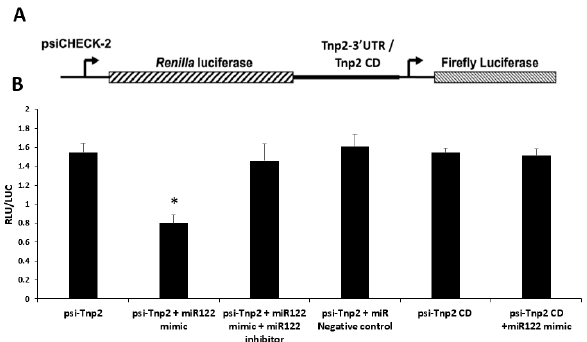
Figure 8. Tnp2 mRNA–miRNA122a interaction. Modulation of translation of Tnp2 depends on the presence of Tnp2 3 ′ UTR region. ( A ) Schematic representation of the psiCheck2 reporter gene carrying the Tnp2 coding sequence with or without 3 ′ UTR. ( B ) Relative luciferase activity in COS-1 cells co-transfected with Tnp2 with 3 ′ UTR reporter constructs (or Tnp2 coding region without 3 ′ UTR) and miR122a mimic and/or miR122a inhibitor or negative control. Asterisks (*) indicate statistically significant change between psi- Tnp2 and psi- Tnp2 + miR122a mimic group (Student’s t-test; p < 0.05). All the data represent means ± SEM from three independent experiments, with each sample running in triplicates.